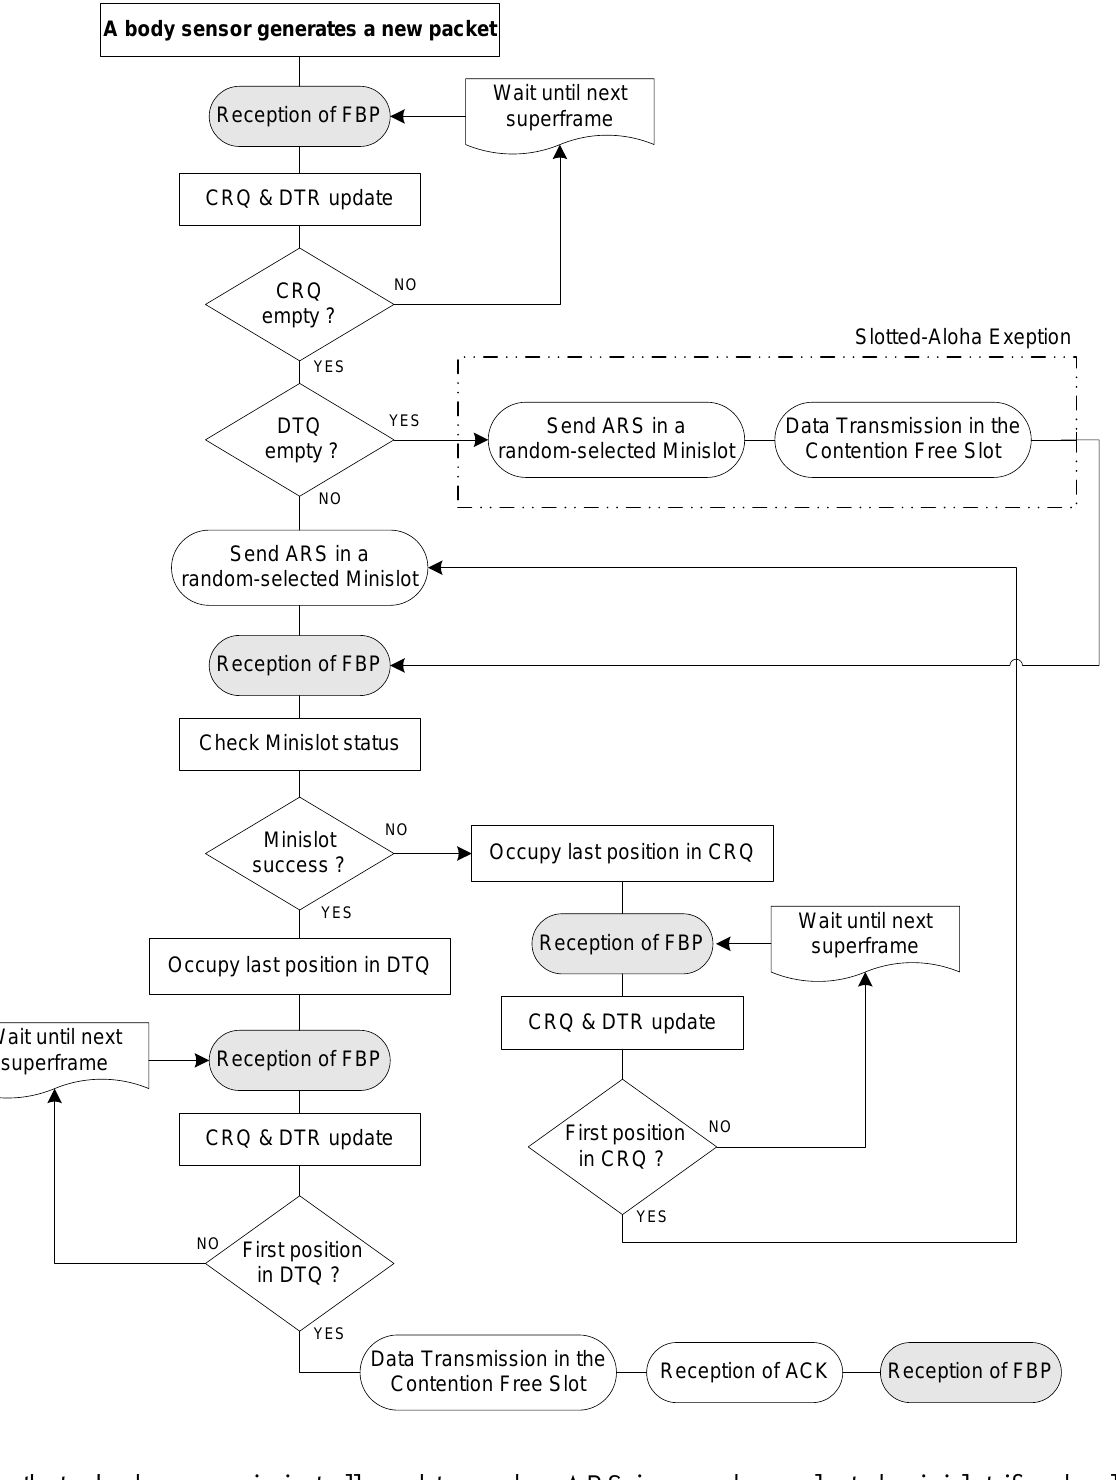
Figure 6. DQ MAC flow chart for energy-saving BSNs based on original DQRAP